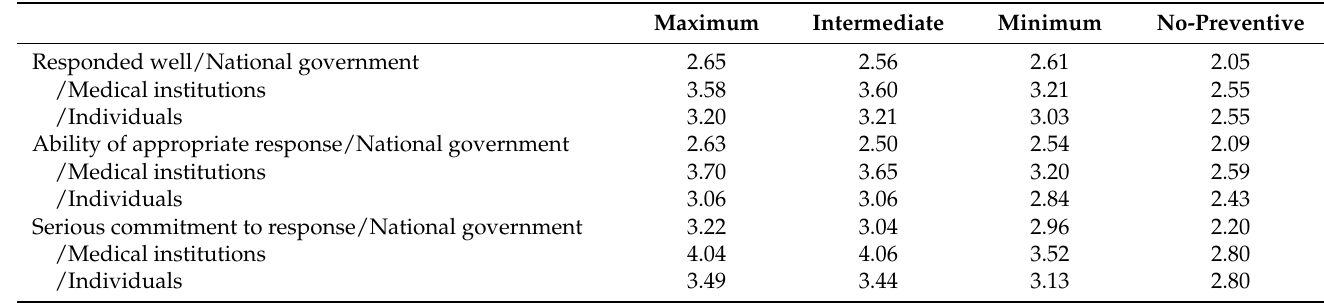
Table 9. Evaluation of the COVID-19 risk management of each